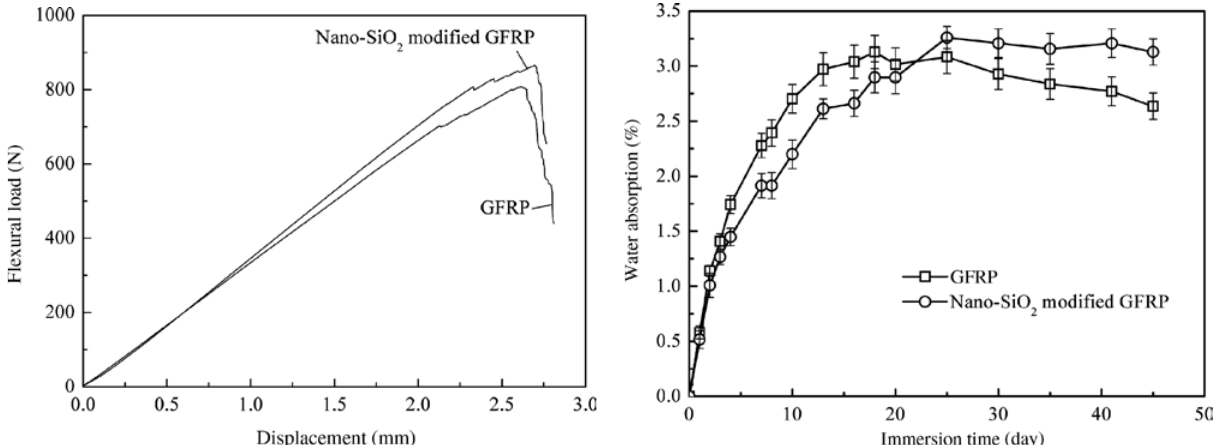
Figure 4: Typical load-displacement curves of the GFRP and nano- SiO modified GFRP under the flexural load condition. 2